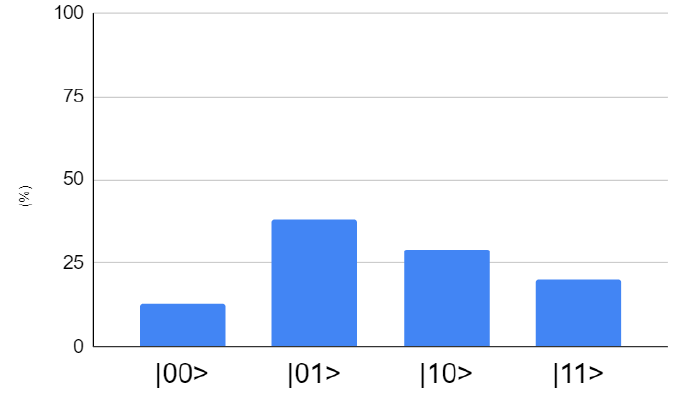
Figure 19. Result of quantum random walk.